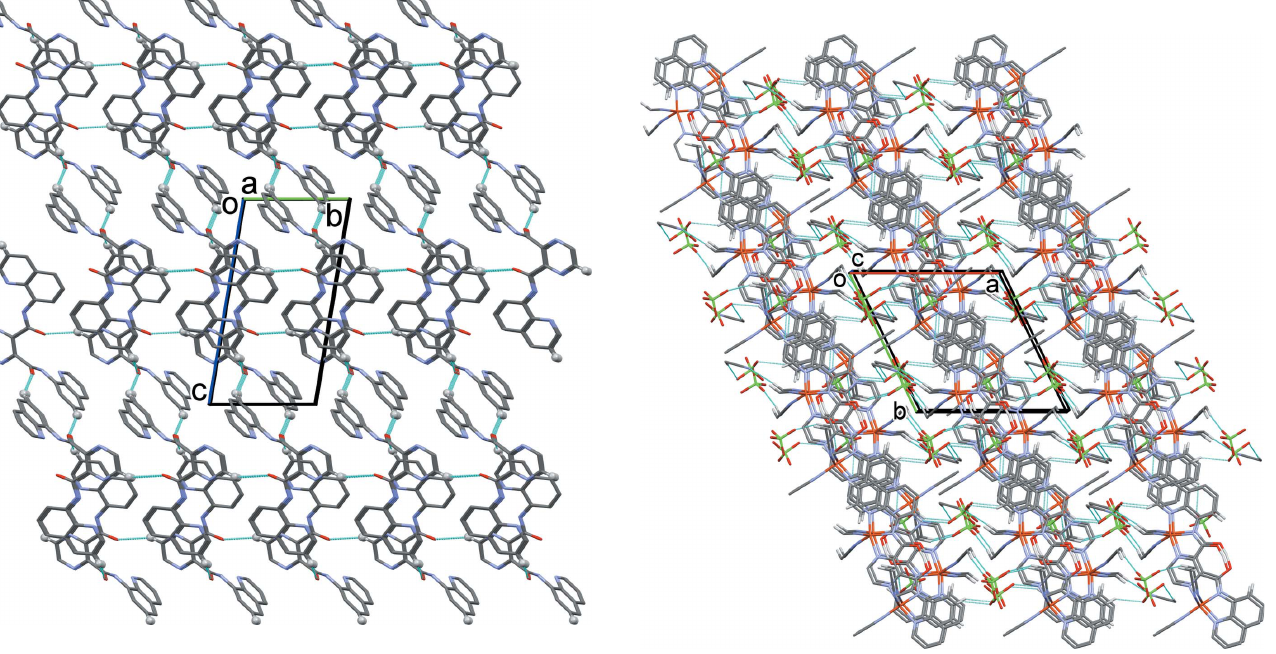
Figure 7 The crystal packing of complex I , viewed along the c axis. Hydrogen bonds are shown as dashed lines (see Table